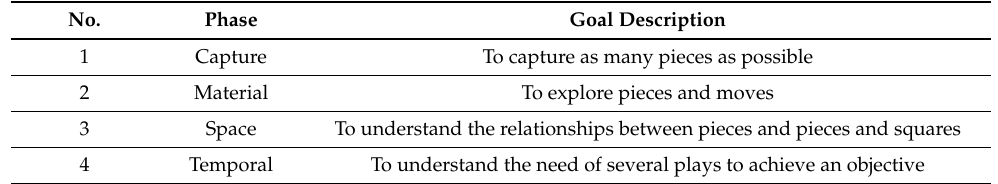
Table 2. Learning phases from the Steps